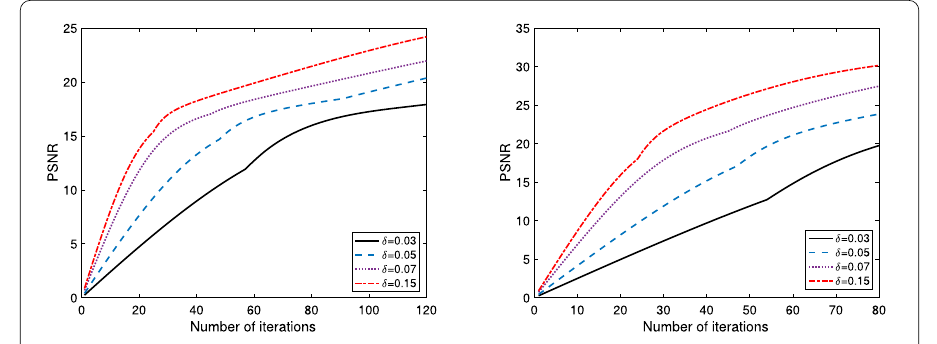
Figure 12 Graph of PSNR value and number of